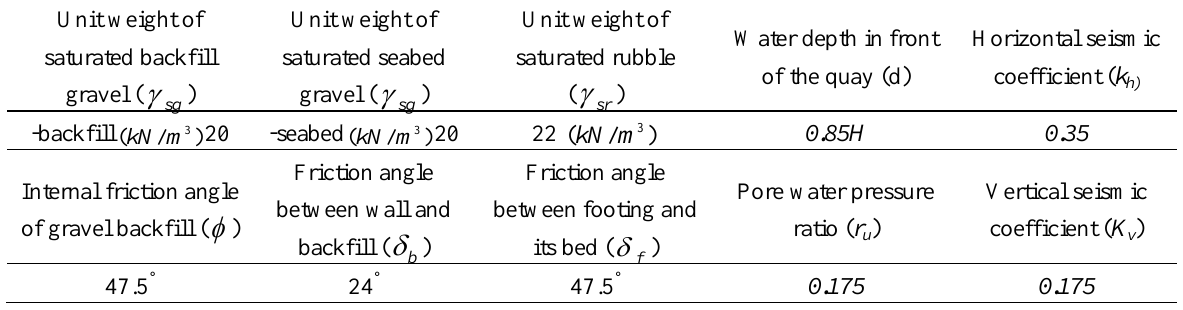
Table 1. Hypothetical values adopted for